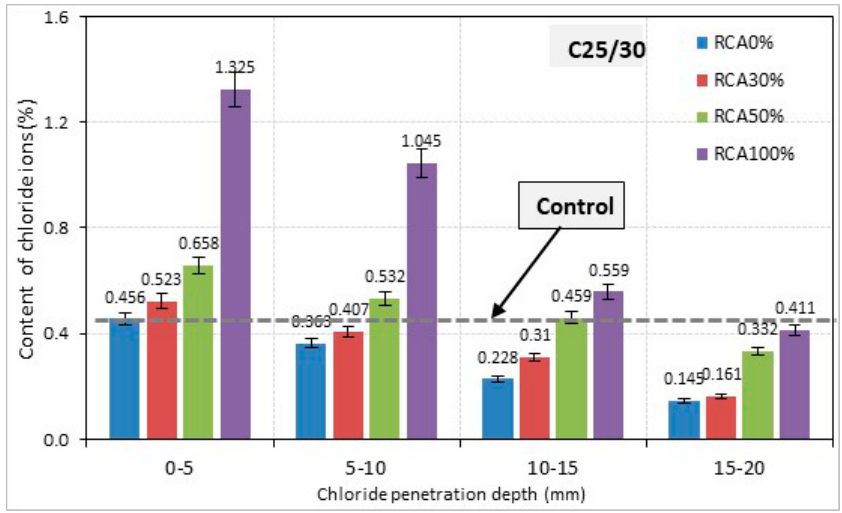
Figure 19. Chloride content versus chloride penetration depth for the C25/30 concrete strength class.